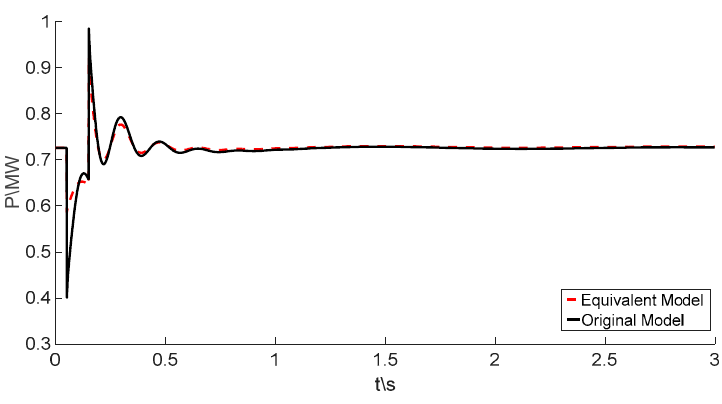
Figure 14. The response of the microgrid in Scenario 3.